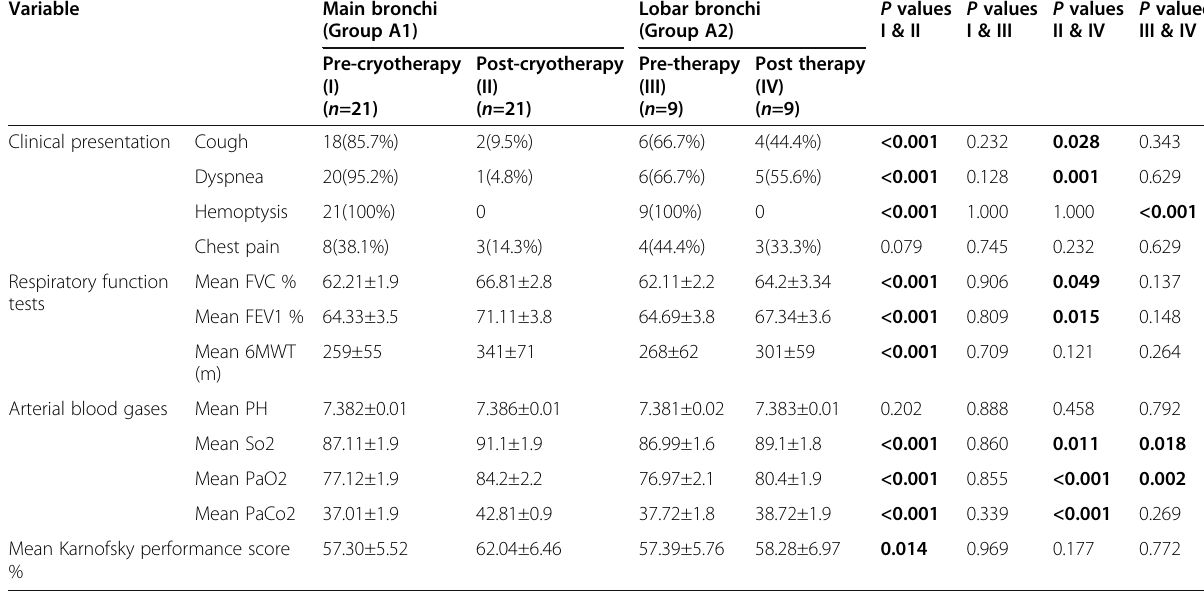
Table 3 Comparison of the clinical presentation outcomes, respiratory function tests, arterial blood gases, and the mean Karnofsky performance score for group A subgroups (main bronchi and lobar bronchi obstruction) Variable